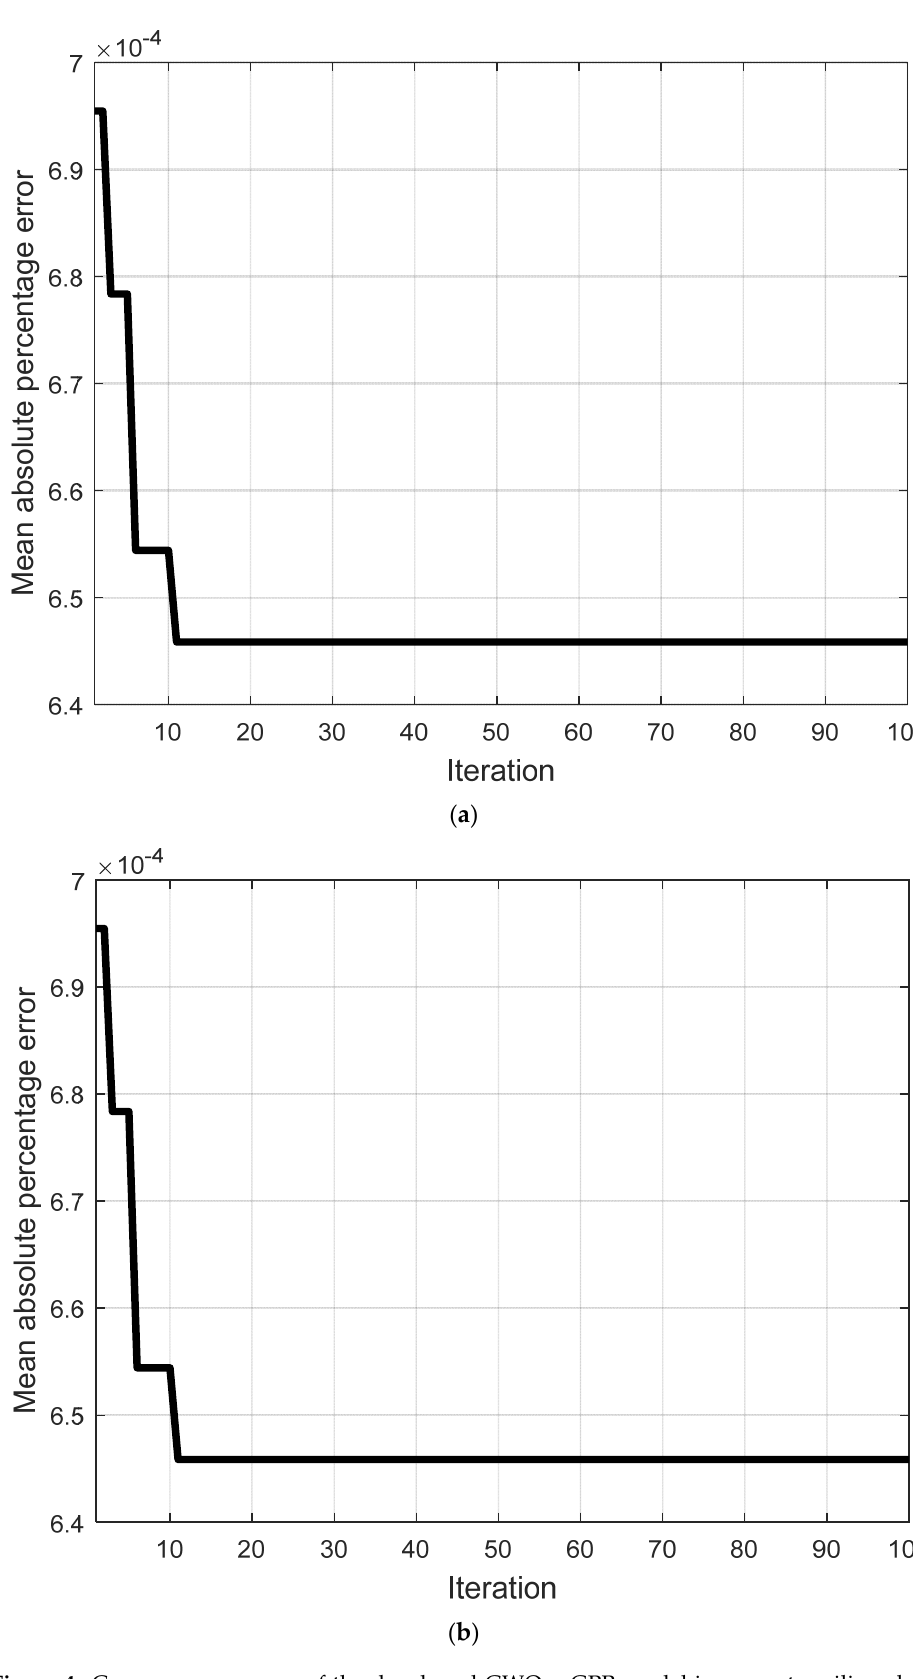
Figure 4. Convergence curves of the developed GWO − GPR model in concrete ceiling slab and concrete interior walls. ( a ) Concrete ceiling slab. ( b ) Concrete interior walls.